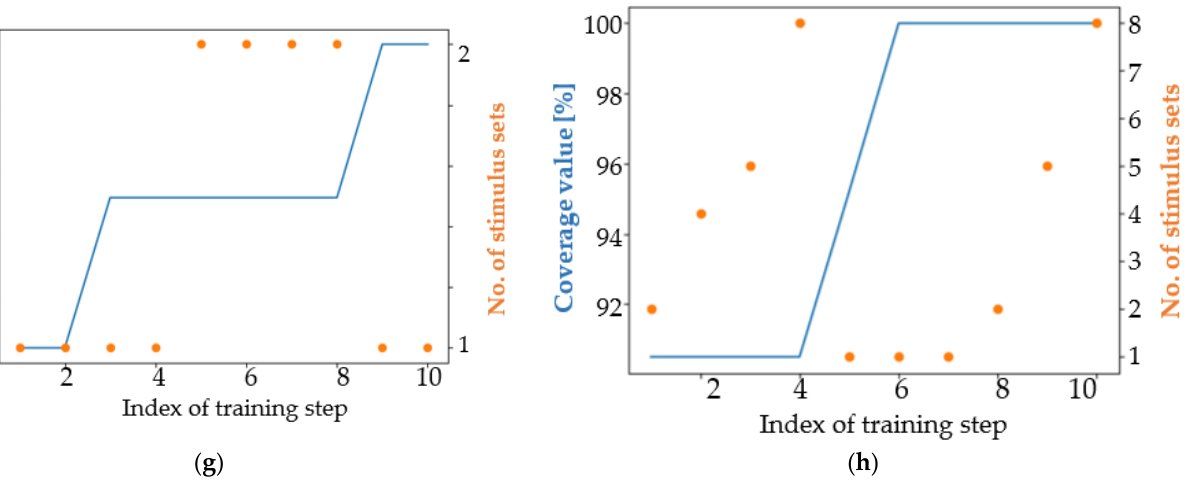
Figure 12. The first 10 iterations of training for each approach, with the primary coverage goal. For the custom developed approaches, the mutation coefficient was updated proportionally considering the number of iterations of the algorithm. The label “proposed” is attached to plots related to the approaches developed and proposed during current study. The blue line shows the coverage value reached by the best performing element in the population at that training step. The orange dots show how many individuals reached the highest coverage value met at each training step. For example, in sub-figure ( g ), at the ninth training step, the population contained only one individual reaching 100% coverage. For sub-figures ( a , g , h ), the best individuals in the initial population reached 85.7% coverage. For sub-figures ( d , e ), the best individuals in the initial population reached 90.5% coverage. For sub-figures ( b , c , f ), the best individuals in the initial population reached a coverage of 95.2%. ( a ) V3.2 (proposed); ( b ) V3.21 (proposed); ( c ) V3.3 (proposed); ( d ) V3.6 (proposed); ( e )